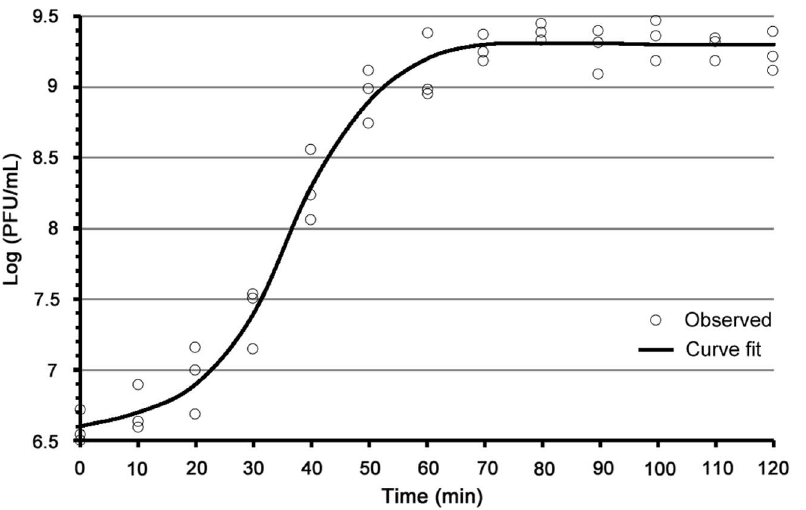
Figure 2. One-step growth curve of phage PaP1. Experiments were repeated three times with duplicate samples. The Y-axis shows the log of plaque forming units per milliliter (PFU/mL).